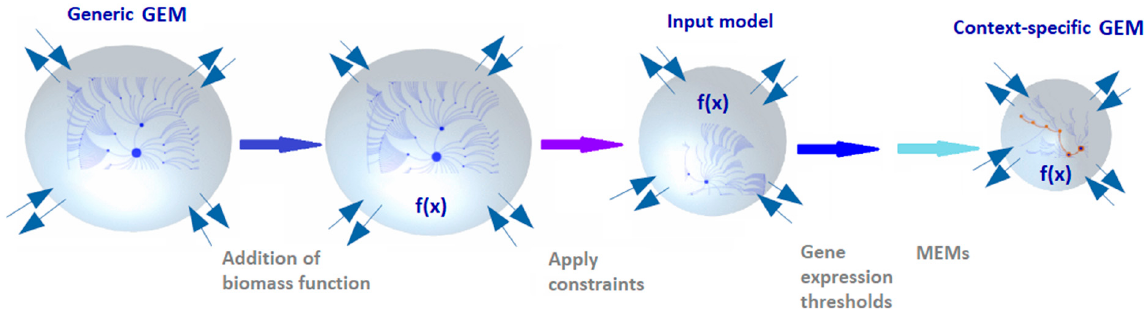
Figure 5. Overview of key steps in the constraint-based modeling process. Extracting a context-specific model representing the metabolism of a tissue type or cell line requires several steps. The most salient steps consist of choosing the kind of generic model to use, the addition of the biomass function, how to constrain the uptake and secretion fluxes in the model, defining of the gene expression threshold to include a gene in a reaction and choosing the MEM algorithm to use for extraction.